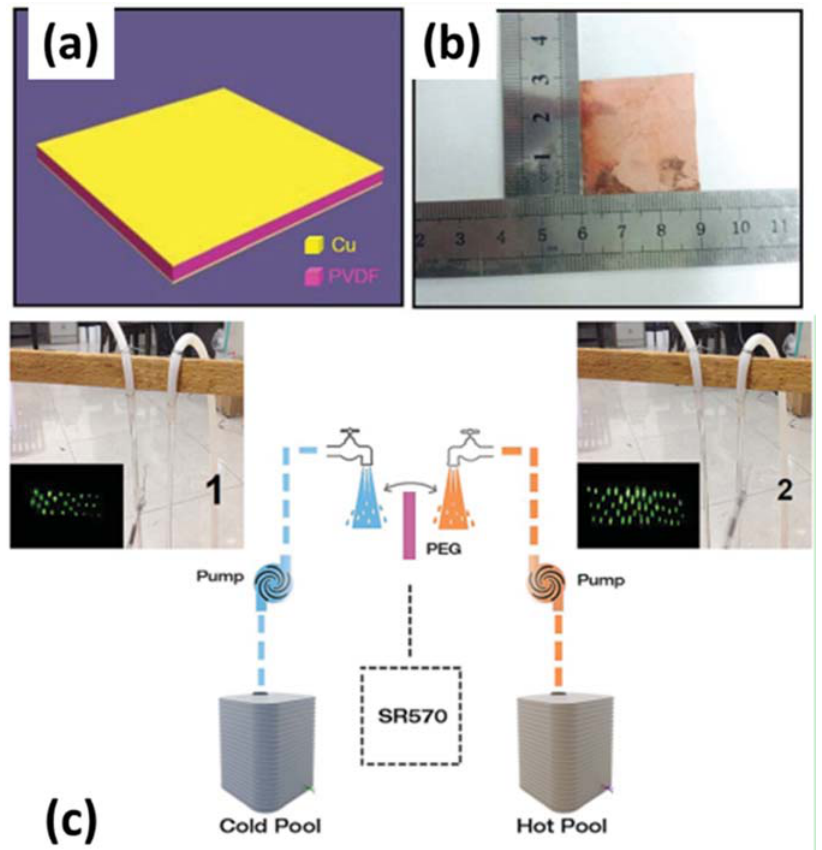
Figure 16. Leng et al.’s pyroelectric generator based on the PVDF film. ( a ) Schematic diagram; ( b ) Digital photograph; ( c ) Experimental setup for testing pyroelectric generators (PEG) under the alternating contact of hot and cold water flow adapted from [138], with permission from © 2014 Royal Society of Chemistry.